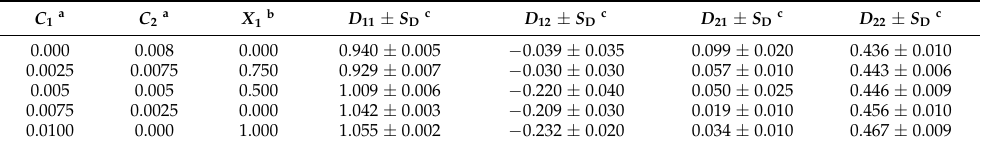
Table 2. Experimental ternary mutual diffusion coefficients, D 11 , D 12 , D 21 , and D 22 , of aqueous NaSal( C 1 ) + β -CD ( C 2 ) solutions at T = 298.15 K and P = 101.3